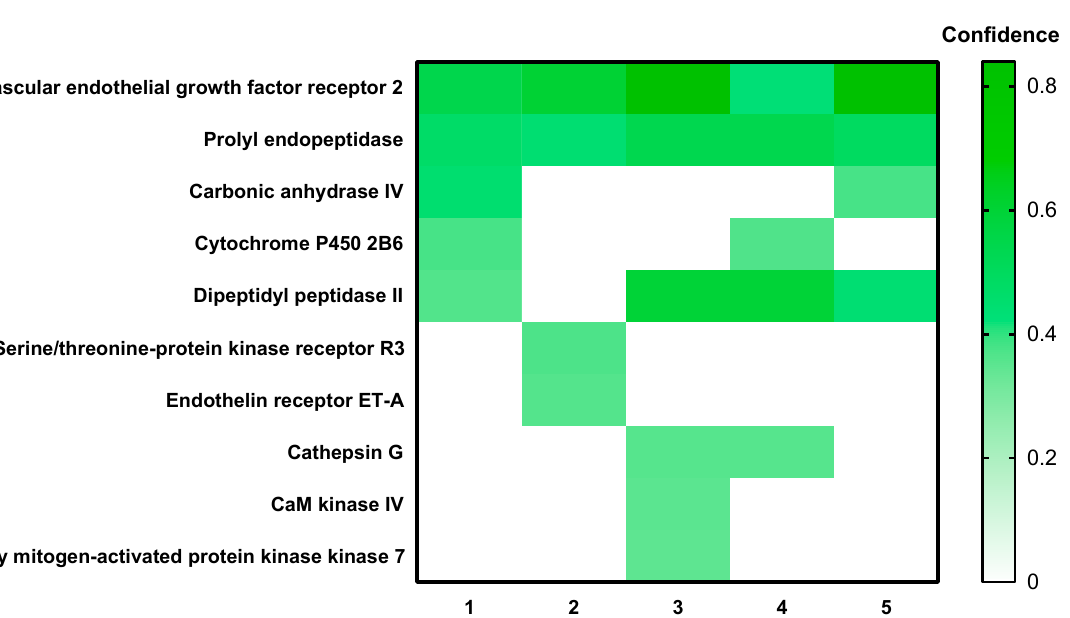
The numbers of compounds on the top indicate the corresponding BCC in Figure 1.